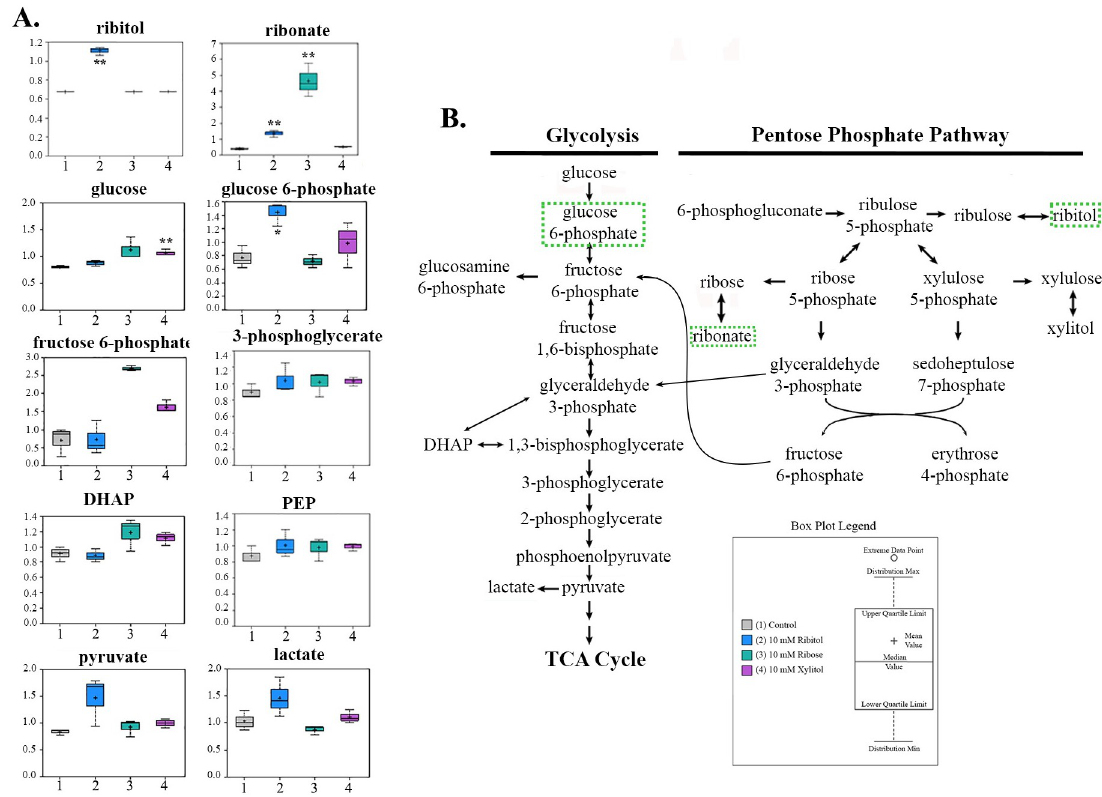
Fig 2. Alterations in glycolysis and the pentose phosphate pathway amongst metabolomic profiles of MCF-7 cells treated with ribitol, ribose, and xylitol. (A) Alterations of various glycolysis intermediates after MCF7 cells treated with ribitol, ribose and xylitol. (B) Hypothetical model of PPP and glycolysis metabolomic interactions after MCF7 cells were treated with ribitol. Significant p > 0 . 05 changes with ribitol indicated with increases in green in pathway schematic. Significance denoted by � p � 0 . 05 , �� p � 0 . 01 , ��� p � 0 . 001 within individual metabolite box plots, as determined by Welch’s two-sample